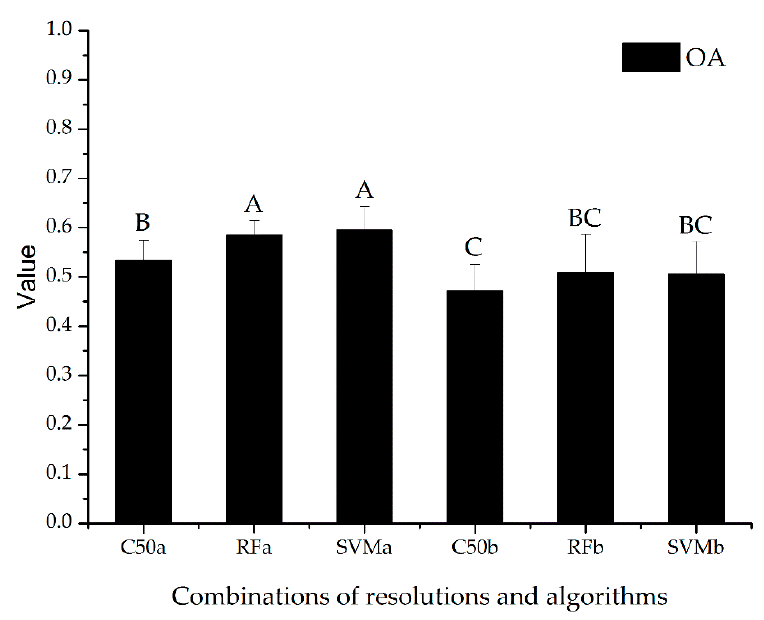
Figure 6. OA of classification for combinations of resolutions and algorithms using S2 images. a: 10 m resolution images; b: 20 m resolution images. Error bars indicate the standard deviations of ten classifications. A–C: pairwise di ff erences among combinations of resolutions and algorithms in the classification performance.